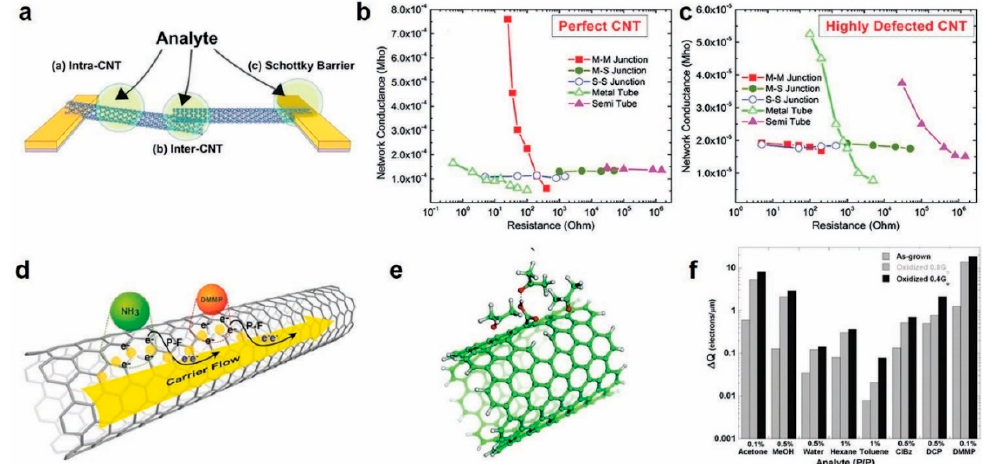
Figure 8. ( a ) Sensing mechanism in CNTs. Reproduced with permission from American Chemical Society [42]. ( b ) Calculations of the effects of changes in the components of the resistance on the overall resistance of the networks for perfect nanotubes and ( c ) defective nanotubes. Reproduced with permission from American Chemical Society [44]. ( d ) Detrapping mechanism of accumulated charges at the nanotube defects in PF regime. Reproduced with permission from AIP Publishing [131] ( e ) Clustering of acetone around the defect via intermolecular bonding. ( f ) Charge transfer between various analytes and the SWNT network as a function of oxidation. Reproduced with permission from American Chemical Society [132].